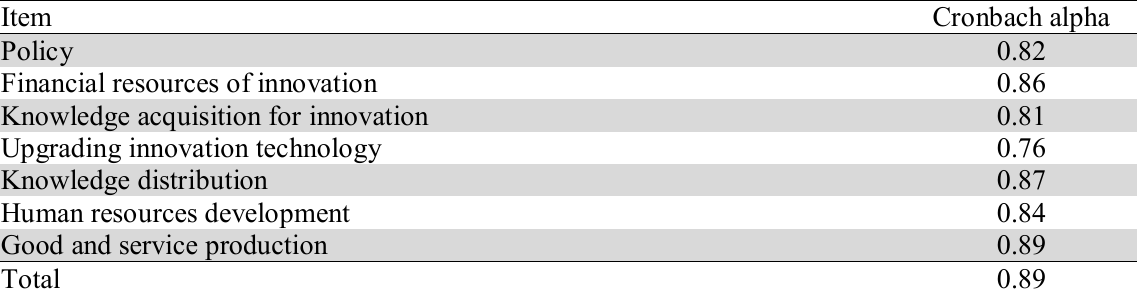
The summary of Cronbach alphas calculated for six items